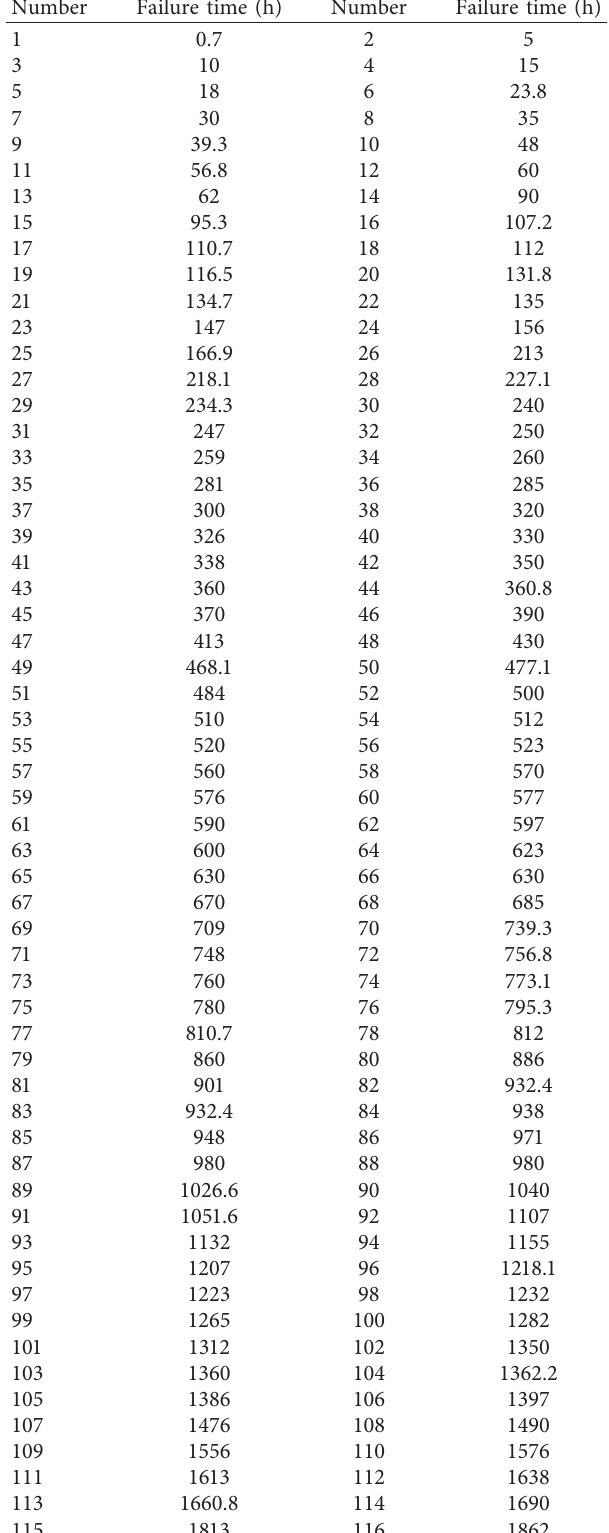
Table 1: Failure time of automatic